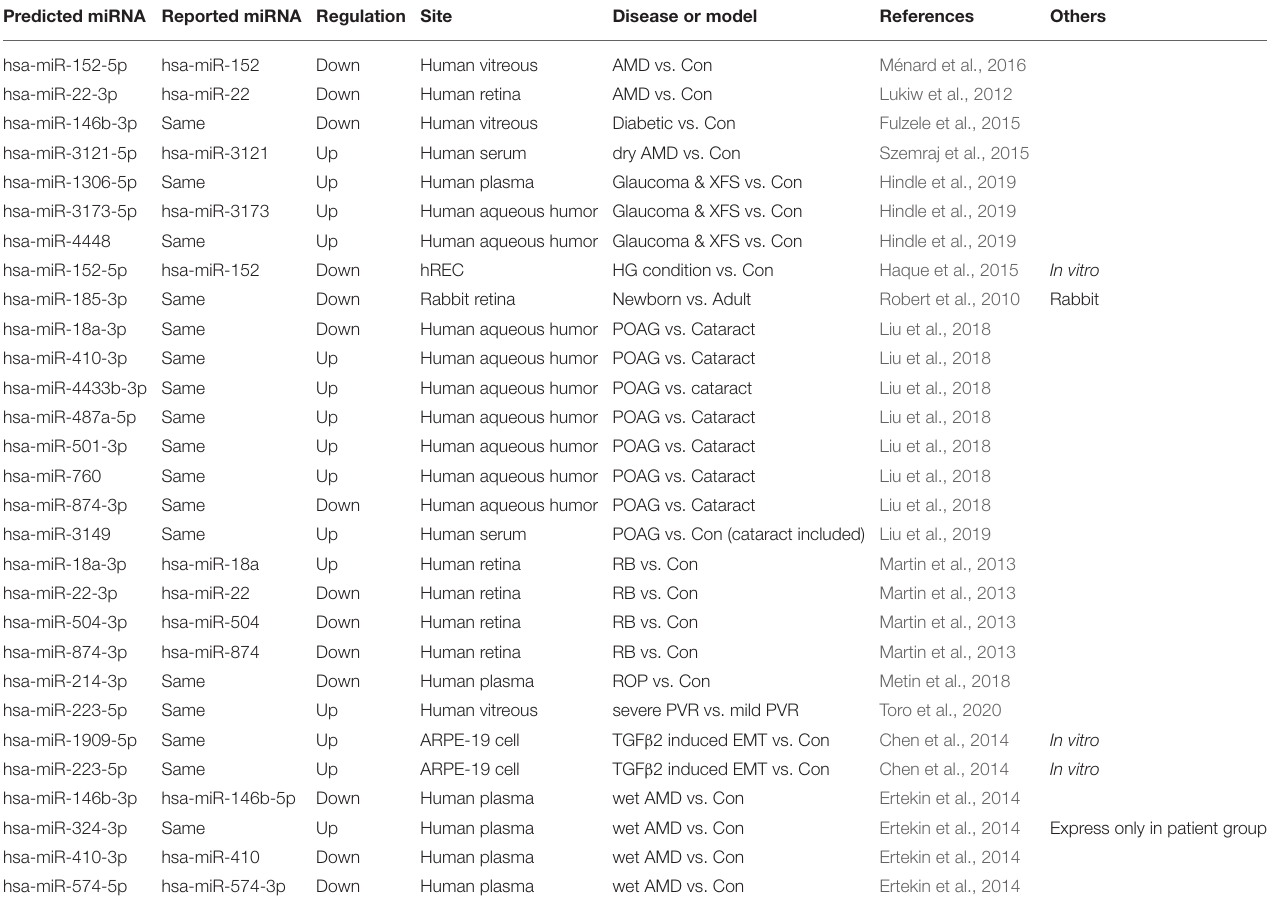
TABLE 1 | Correlation of predicted microRNA in regulating IRBP and retinal disease. Predicted miRNA Reported miRNA Regulation Site Disease or